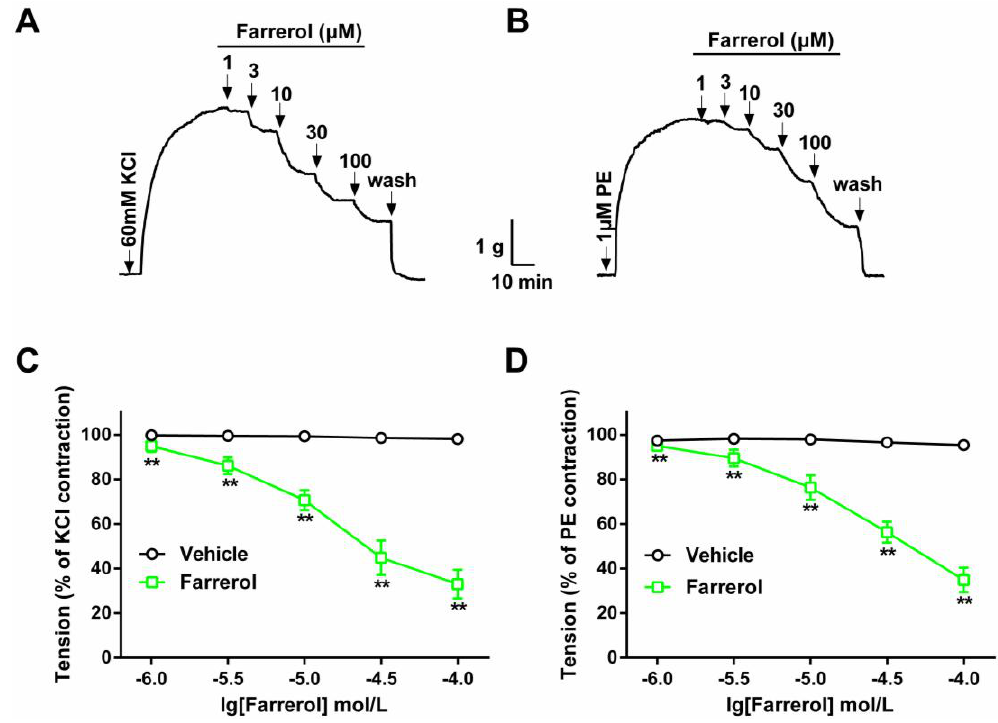
Figure 1. Dose-dependent relaxant effects of farrerol on isolated rat aortic rings. Typical original traces of the effects of farrerol on KCl- ( A ) or PE-induced ( B ) contractions. The vertical arrows indicate drug addition. Concentration-dependent effects of farrerol (1–100 µM ) on KCl- ( C ) or PE-precontracted ( D ) rat aortic rings. The Student’s t -test was used in the statistical analysis. Data are expressed as means ± SD ( n = 6–8). ** p < 0.01, vs .